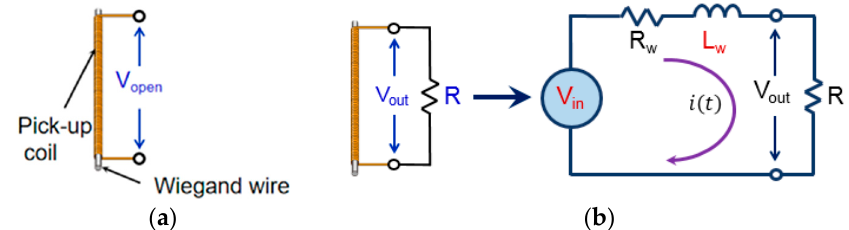
Figure 3. ( a ) Open-circuit voltage and ( b ) equivalent electrical circuit model of the Wiegand sensor.